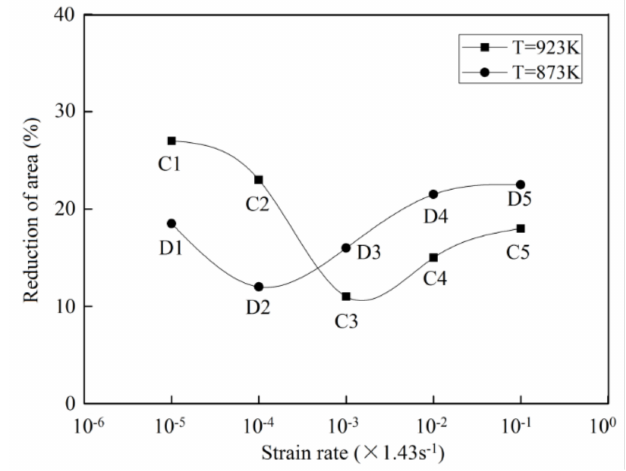
Figure 7. Reduction of area (RA) as a function of strain rate for an Fe-17Cr steel determined at 923 K (C) and 873 K (D) after Figure 3, showing strain rate embrittlement ((1) . . . ε = 1.43 × 10 − 4 s − 1 , (3) ε = 1.43 × 10 − 3 s − 1 , (4) ε = 1.43 × 10 − 2 s − 1 , and (5) (2) plotted from the data in Figure 3). Adapted from ref. [4].